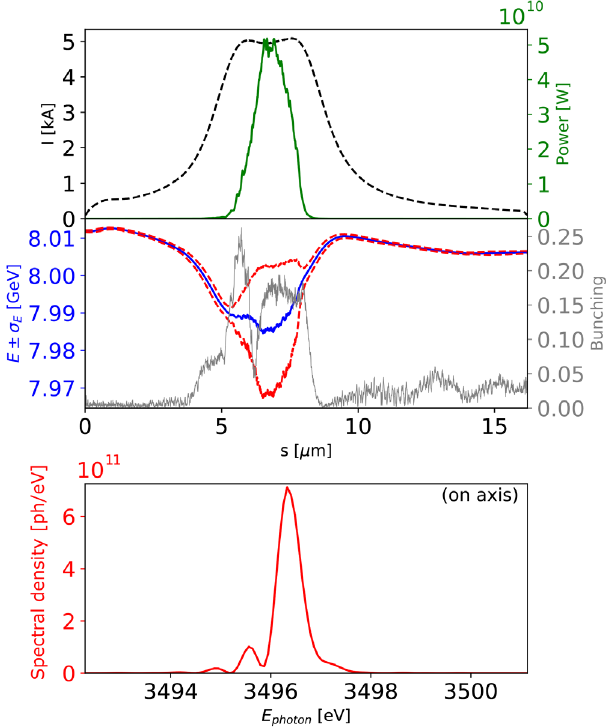
FIG. 12. Output from the 4 þ 4 setup followed by six untapered undulator segments. The red-dotted lines in the middle plot show (cid:3) σ in the electron energy distribution, the average being shown in